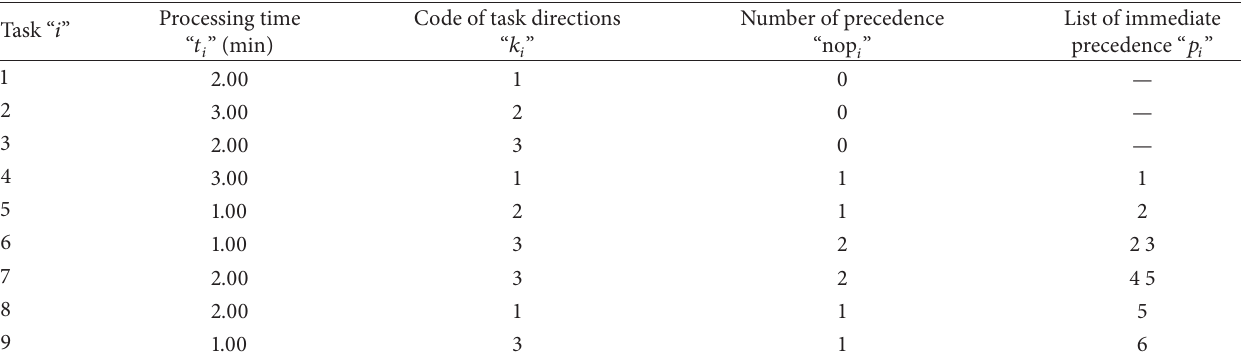
Table 12: Data of problem P9, CT = 4, 5, and 6min [2].